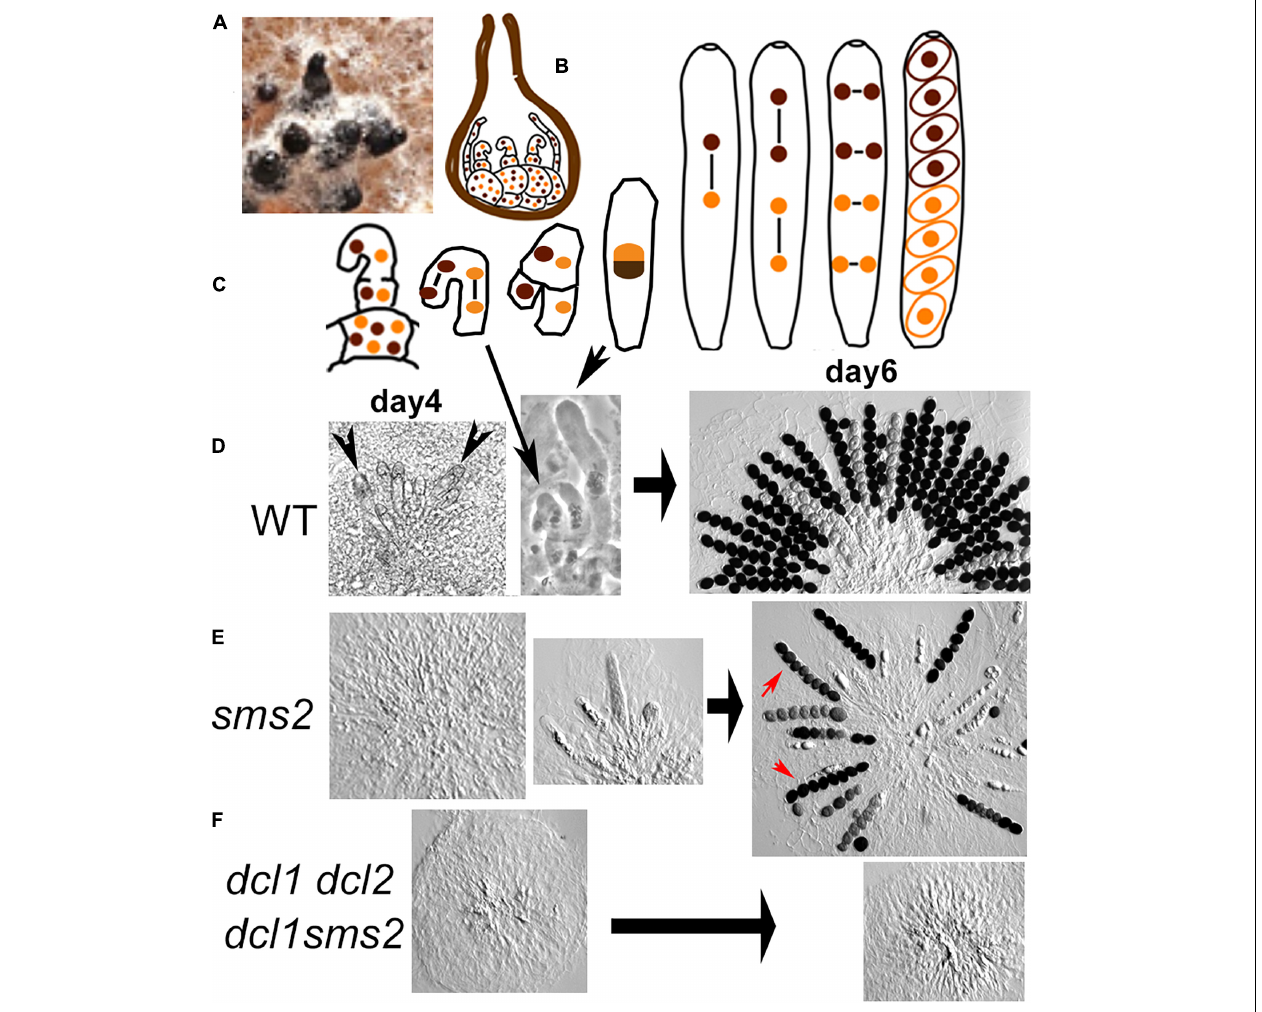
FIGURE 1 | Meiocyte formation and sporulation in wild type, dcl1, and double mutants. (A) Six bottle-shaped perithecia (black) developed on growing mycelium (white) on agar medium (brown). (B) Drawing of a section through a perithecium in which binucleated cells (middle) and paraphyses (two on both sides) have started to develop from the ascogonium multinuclear cells (at the base). (C) Progression from crozier to ascus formation, followed by karyogamy, the two meiotic divisions, a post-meiotic division and ascospore delimitation in wild type (WT). (D–F) Light micrographs of asci dissected out from perithecia. (D) Left and middle: WT young perithecia contain several small asci (arrowheads, left), intermingled with croziers (long arrow, center); right: mature perithecium with eight-spored asci (half of the asci presented here). (E) Left, middle and right: corresponding sms2 stages. Note the reduced number of asci when compared to WT, the small number of asci with eight regularly shaped ascospores (red arrows) and the presence of abnormal, often aborted ascospores in the other asci. (F) Perithecia of the two double mutants contain paraphyses but no asci even after 6 and 14 days.